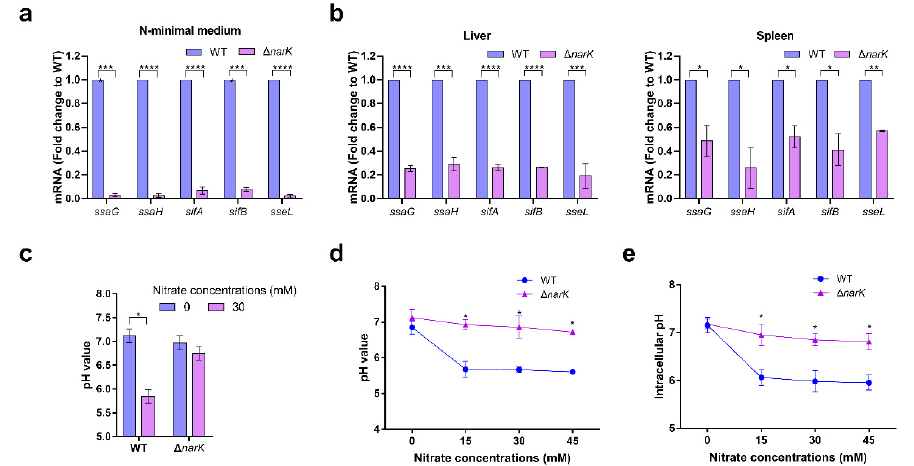
Figure 4. Nitrate utilization increases the intracellular acidification of S. Typhimurium to activate SPI-2 virulence gene expression. ( a ) qRT-PCR analysis of the mRNA levels of five SPI-2 genes in S. Typhimurium WT and the ∆ narK mutant. Bacteria were grown in N-minimal medium supple- mented with 30 mM nitrate for 6 h. ( b ) qRT-PCR analysis of the mRNA levels of five SPI-2 genes in S. Typhimurium WT and the Δ narK mutant that were extracted from mouse liver and spleen at day 3 post-infection. ( c ) S. Typhimurium WT and Δ narK mutant were cultured in N-minimal medium in the presence or absence of 30 mM nitrate for 6 h. Changes in the pH of the medium were assessed . ( d ) S. Typhimurium WT and Δ narK mutant were cultured in N-minimal medium in the presence of 0, 15, 30, or 45 mM nitrate for 6 h. Changes in the pH of the medium were assessed . ( e ) S. Typhi- murium WT and Δ narK mutant were cultured in N-minimal medium in the presence of 0, 15, 30, or 45 mM nitrate for 6 h. Changes in the intrabacterial pH were assessed using a BCECF-AM fluores- cent probe . ( a – e ) Data were generated from three independent experiments and are presented as mean ± SD. p -values were determined using unpaired Student’s t -test (* p < 0.05; ** p < 0.01; *** p < 0.001; **** p < 0.0001).